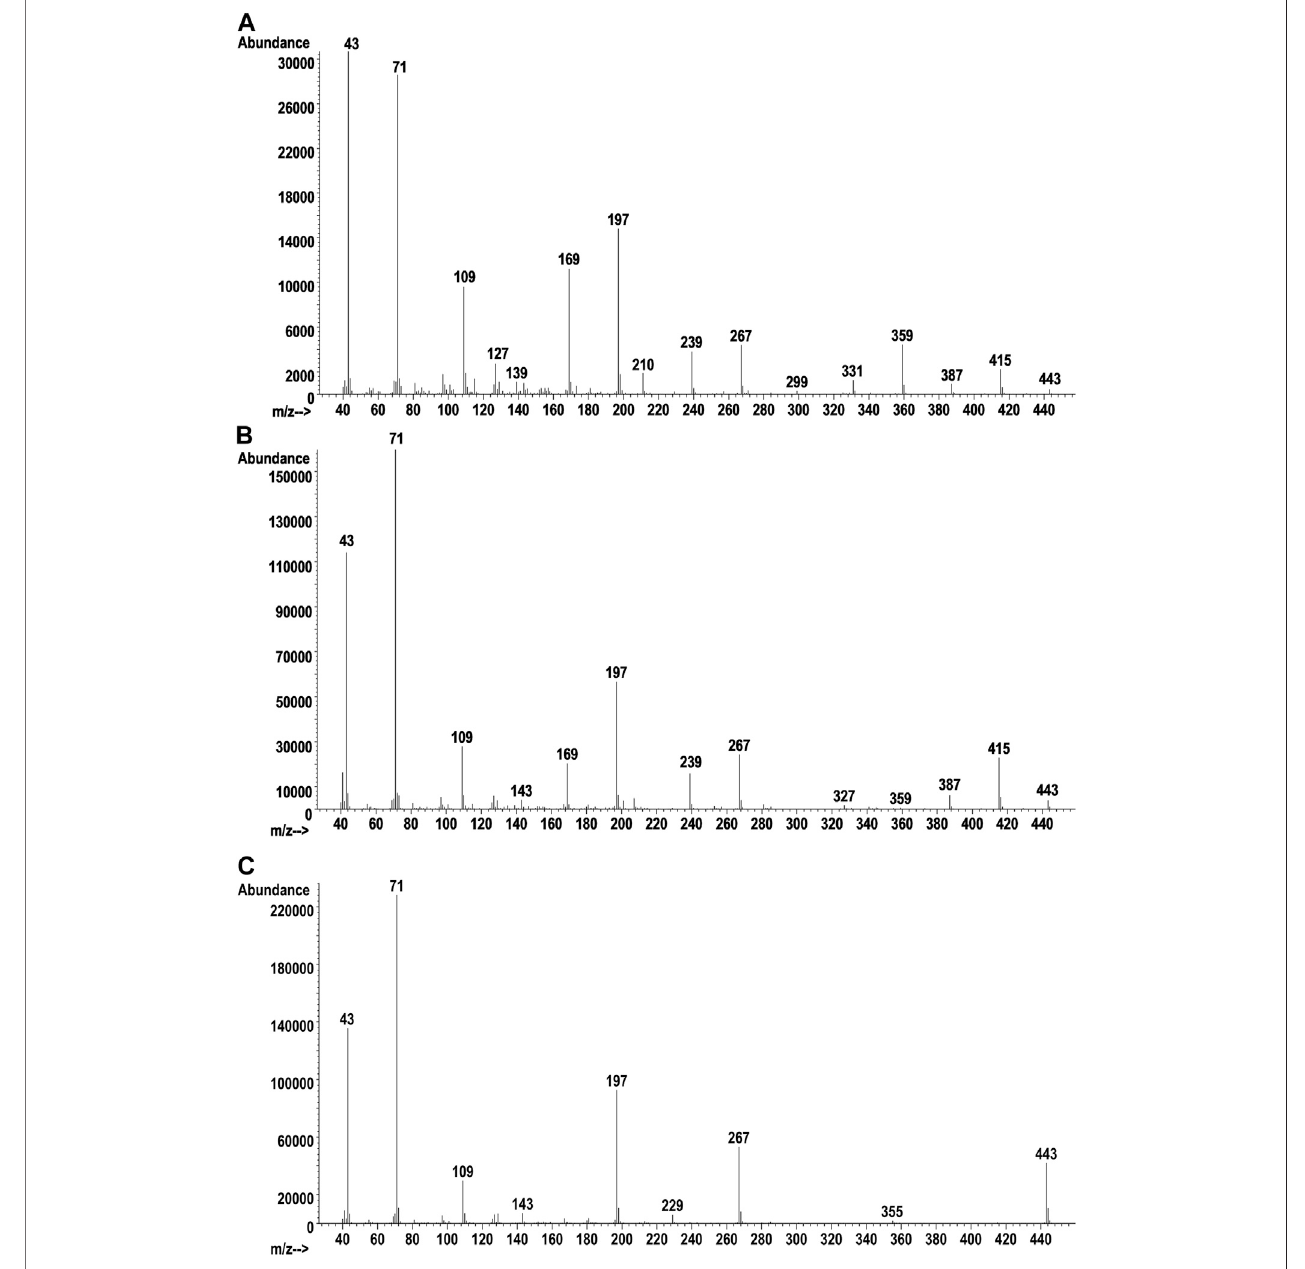
FIGURE 10 | Vaping liquid SAIB component GC-MS spectra for earliest eluting peak ( A , 28.6 min), mid eluting peak ( B , 31.6 min), and last eluting peak ( C , 34.4 min).